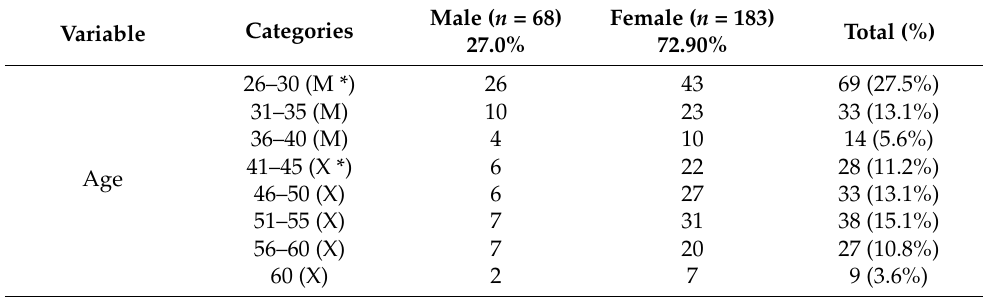
Table 1. Sociodemographic profile of the